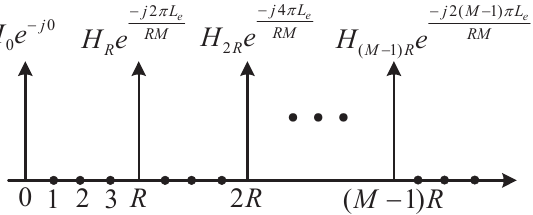
Figure 6. Estimation of the channel and timing synchronization error by using branch r = 0 in SR-OFDM, taking R = 4 as an